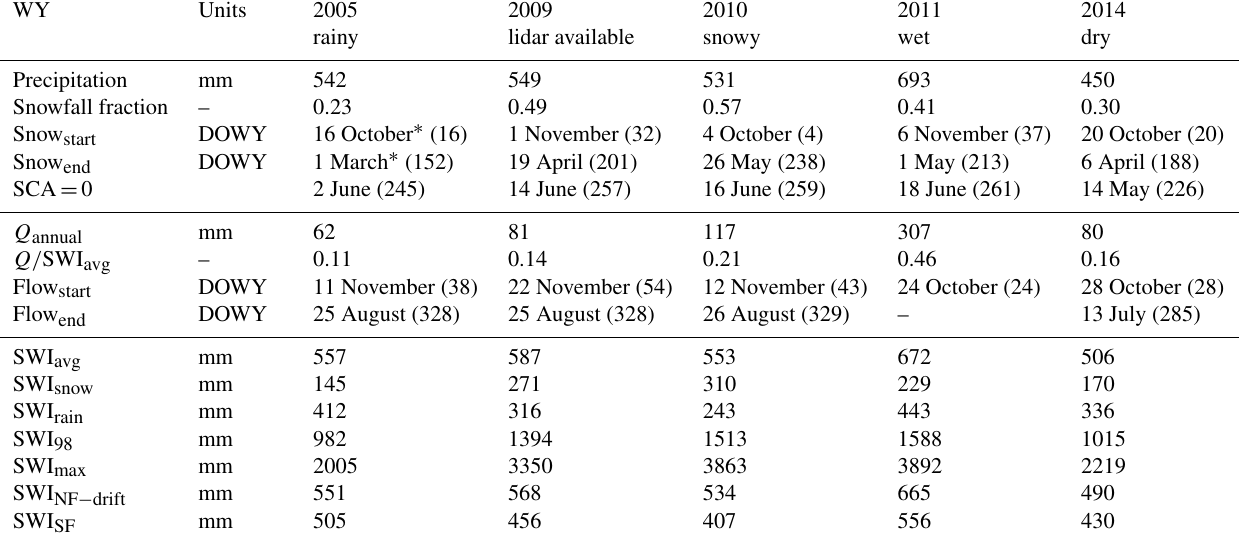
Table 1. Precipitation, discharge, and SWI characteristics for each water year including total precipitation (average of precipitation measured at jd124b and jd125); the fraction of precipitation falling as snow (snowfall fraction); date and DOWY (day of water year) of the start of the snowy season (snow start ); date of the end of the snowy season (snow end ), defined as < 1cm of snow at weather station jd124b (except for 2005, for which only data for weather station jd125 were available); date on which the simulated snow cover had melted (melt-out date; SCA = 0); annual discharge ( Q annual ); runoff efficiency ( Q annual / SWI avg ); the start (Flow start ) and end (Flow end ) of surface